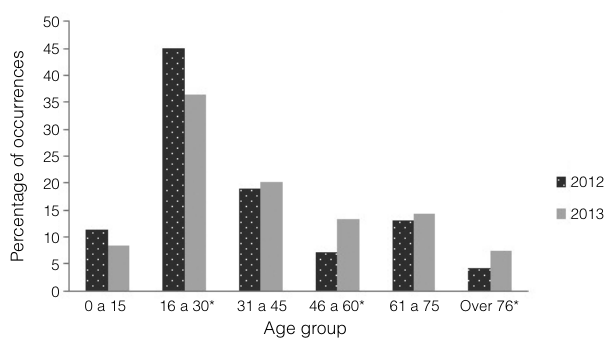
Age group figurE 2 – Distribution of infections by Escherichia coli according to the age group of patients seen at CIS-COMCAM CIS-COMCAM: Consórcio Intermunicipal de Saúde da região da Comunidade dos Municípios da Região de Campo Mourão.